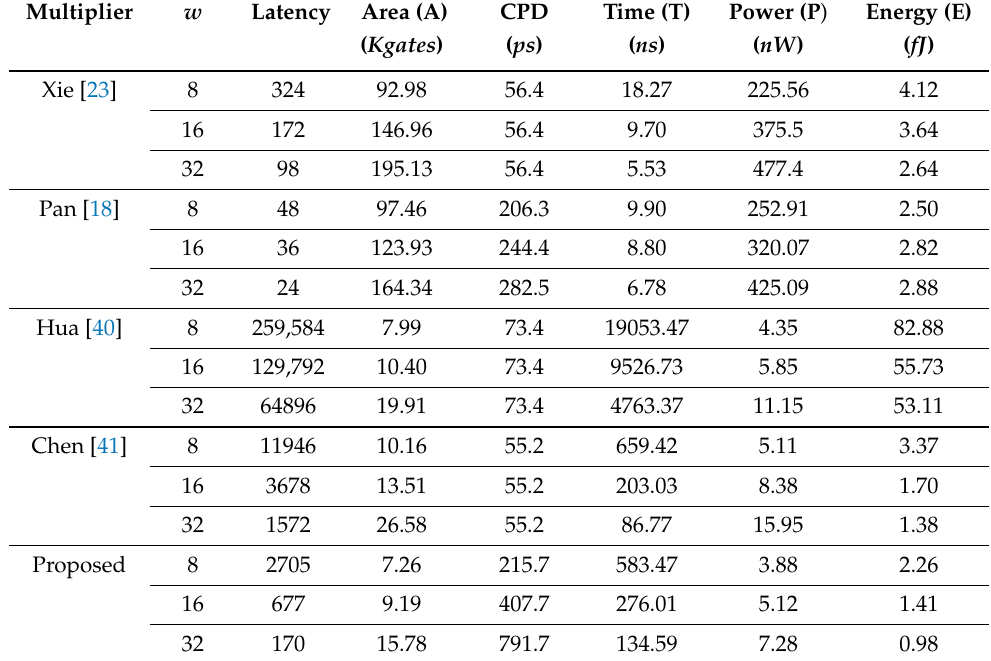
Table 2. Implementation results of different word-serial field multipliers for m = 409 and different values of w